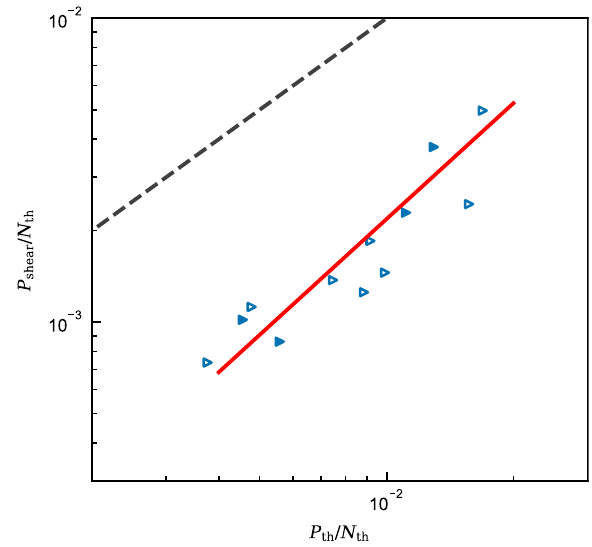
Fig. 5 | Comparison of different measures of TKE production. Log-log plot of depth-integratedshearproductionagainsttop-hattotalenergylossofamean fl ow e w U 3 . The power-law correlation (Eq. (7)) is depicted by a red solid P th = u 2 * U + 1 2 line.Greydashed lineindicatesthe lineof equality( P shear = P th ).Dataarecalculated from the empirical measurements reported by Islam and Imran 36 . Symbols as per Fig. 1.